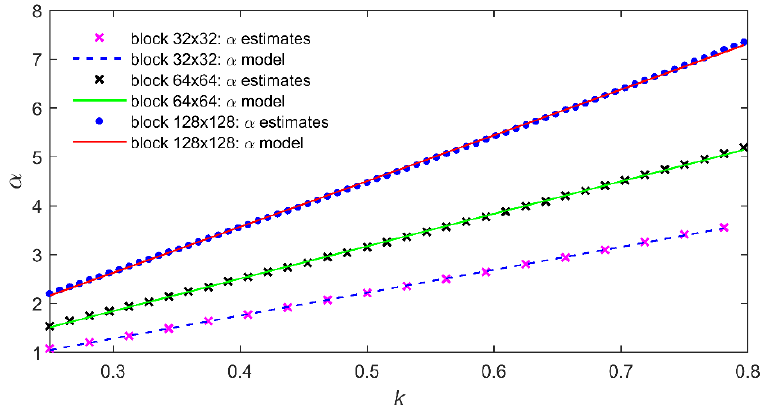
Figure 4. The scatterplot of parameter α against the normalized singular value tail length k and the proposed linear model.